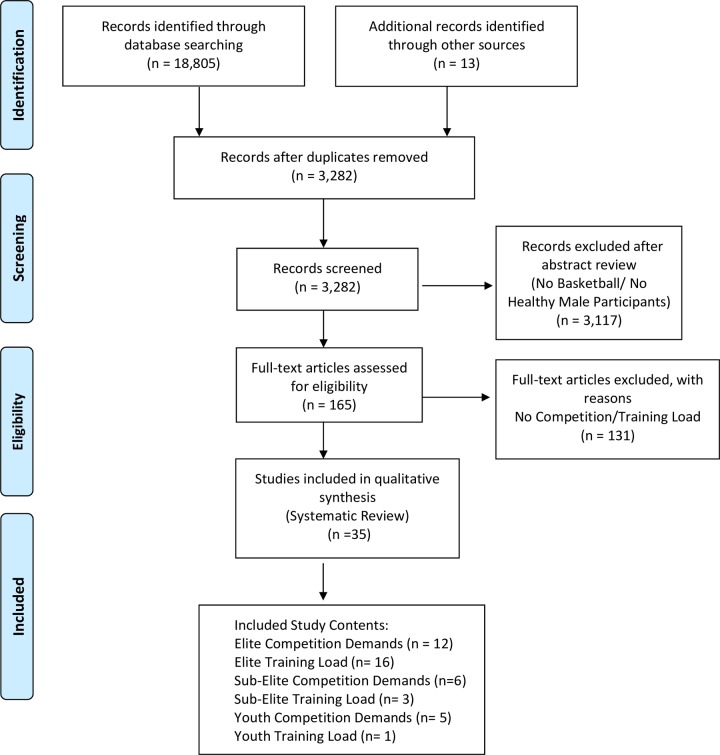
PRISMA flow diagram.